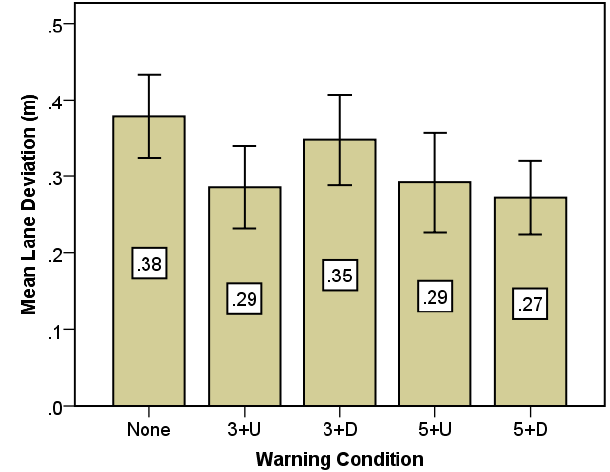
Figure 7. Mean lane deviation comparison under different warning conditions.